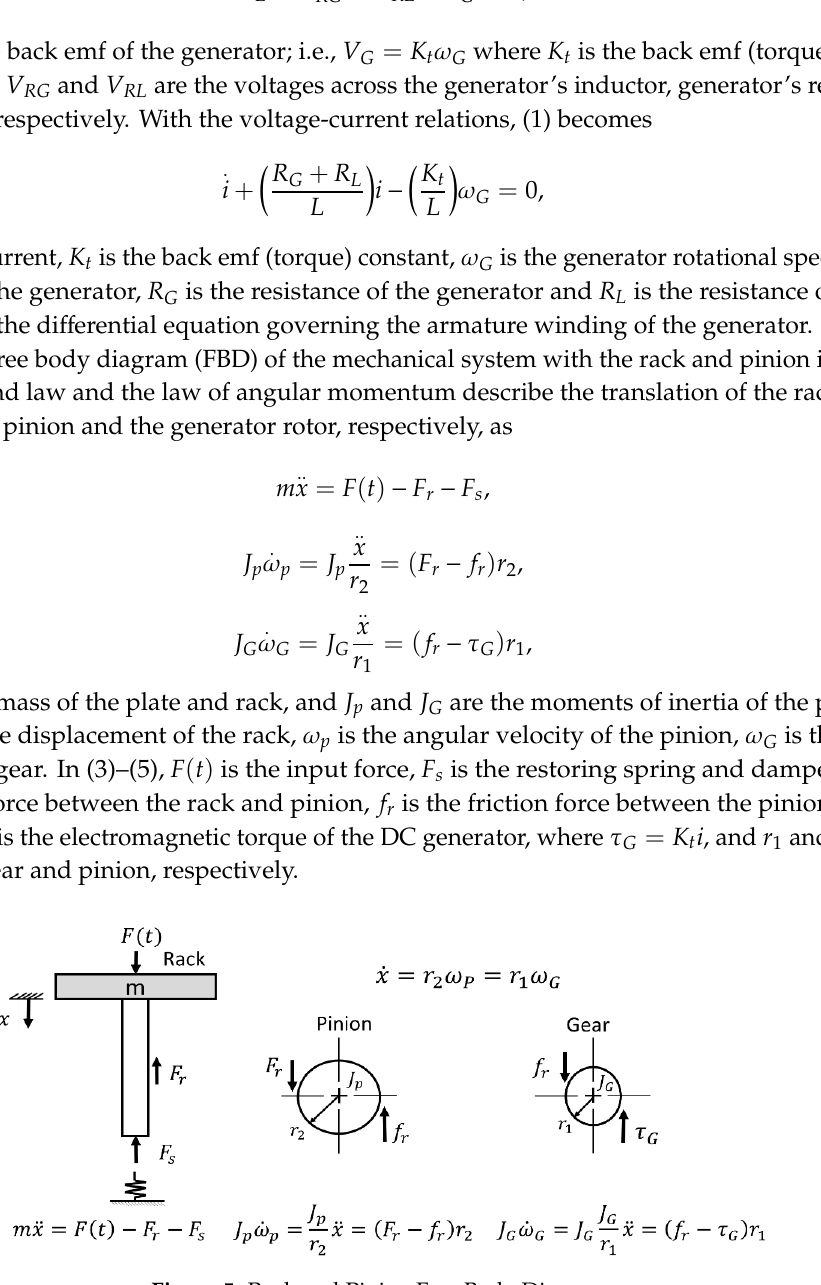
Figure 5. Rack and Pinion Free Body Diagram.